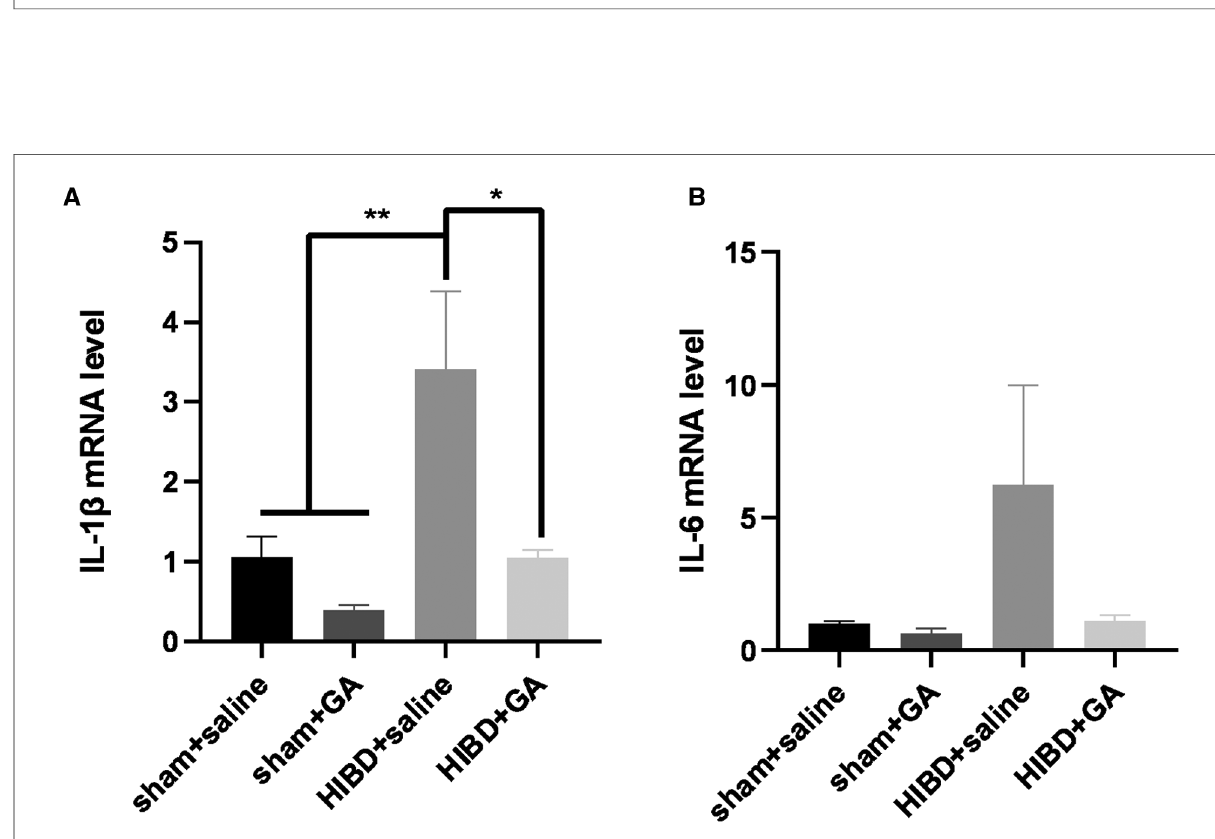
FIGURE 3 Ga inhibits OGD/R-induced ROS and in fl ammatory cytokines generation. (A) Quanti fi cation of ROS generation in BV2 cells. The mean fl uorescence intensity of the control group without GA treatment was used to normalize for analysis. GA treatment reduced the overproduction of ROS induced by OGD/R ( n =5). The increased mRNA levels of IL-1 β (B) and IL-6 (C ) in OGD/R group were rescued with GA treatment ( n =3). Data are presented as mean±SEM. * P <0.05, ** P <0.01, *** P <0.001.